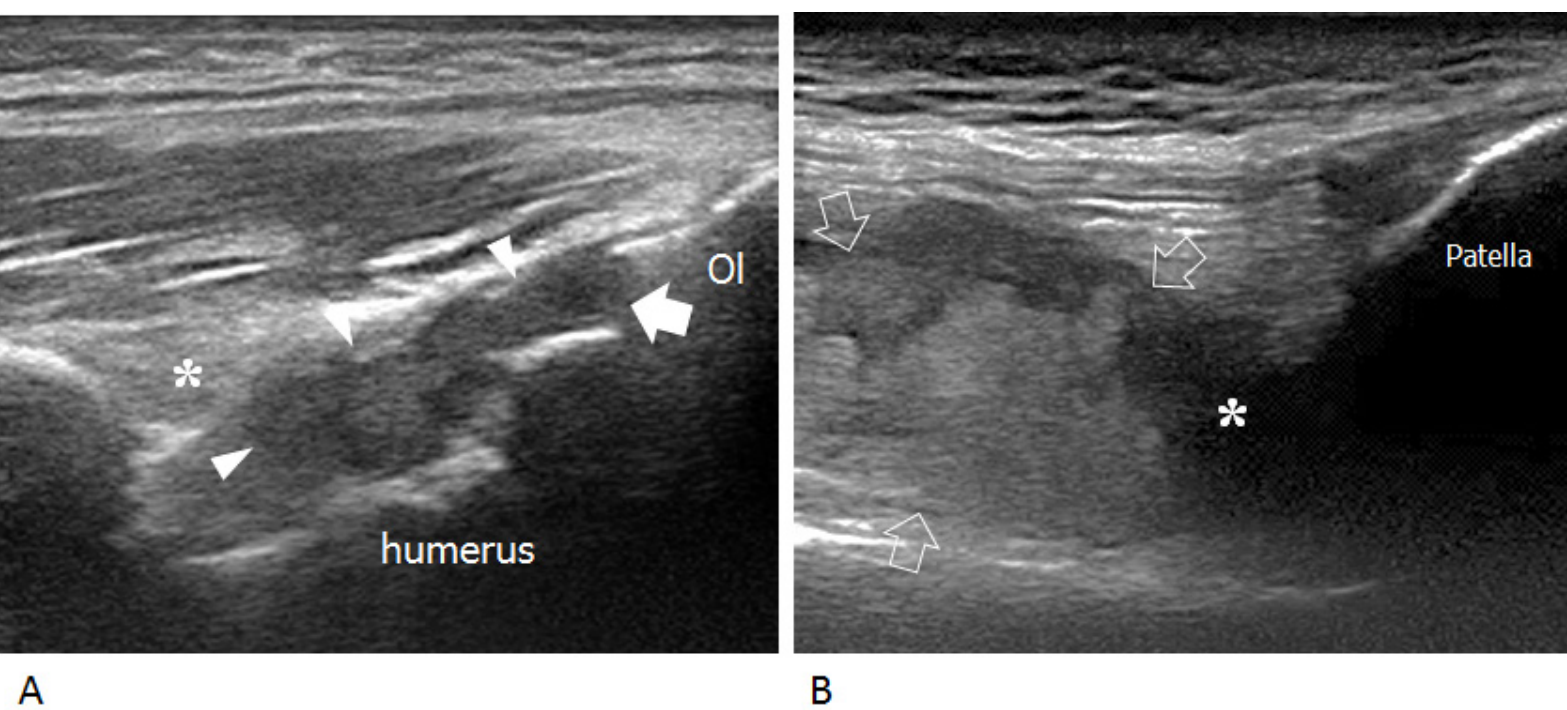
Figure 1. Intraarticular chronic synovial proliferation. ( A ) Longitudinal US image of the posterior elbow demonstrates synovial hypertrophy distending the olecranon recess (arrowheads) and elevating the posterior fat pad (asterisk). The joint line (arrow) is delimited by the olecranon (Ol) and posterior aspect of the humeral trochlea. ( B ) Longitudinal US image of the anterior knee shows marked distension of the suprapatellar recess by synovial hypertrophy (arrows) and effusion (asterisk).